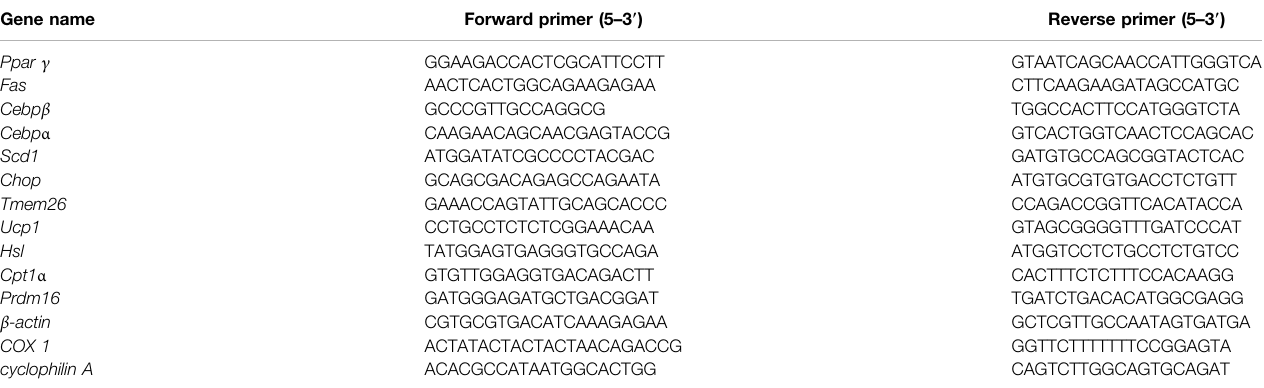
TABLE 1 | Oligonucleotide Primers Used for